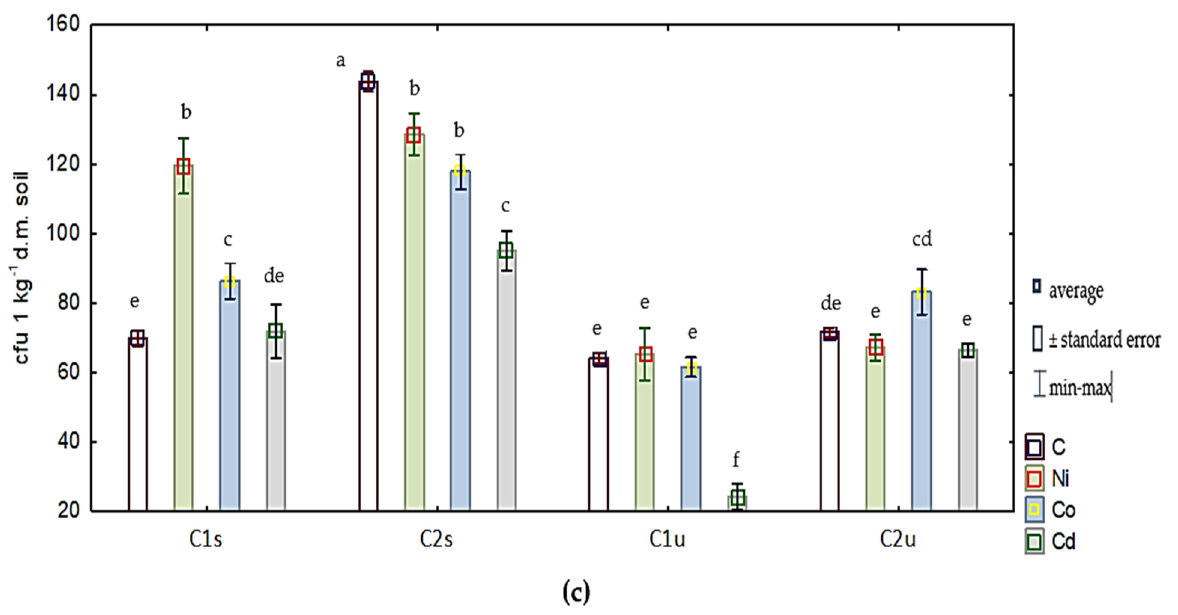
Figure 2. Microbial counts (CFU) in 1 kg soil d.m. ( a ) organotrophic bacteria 10 9 ; ( b ) actinobacteria 10 9 ; ( c ) fungi 10 7 ; heavy metal dose in 1 kg d.m. soils: C—control; Ni—400 mg; Co—80 mg; Cd—8 mg; C1s—soil not fertilized with compost, sown with Festuca rubra ; C2s—soil fertilized with compost, sown with Festuca rubra ; C1u—soil not fertilized with compost, not sown with Festuca rubra ; C2u—soil fertilized with compost, not sown with Festuca rubra ; homogeneous groups within each microbial group are marked with identical letters (a–i).